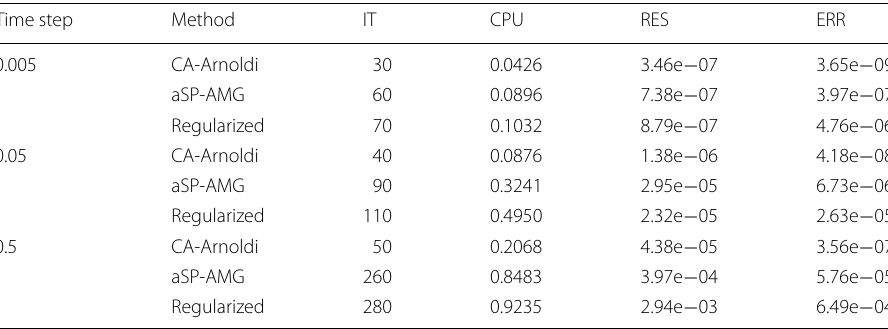
Table 3 Numerical results for the tested iteration methods Time step